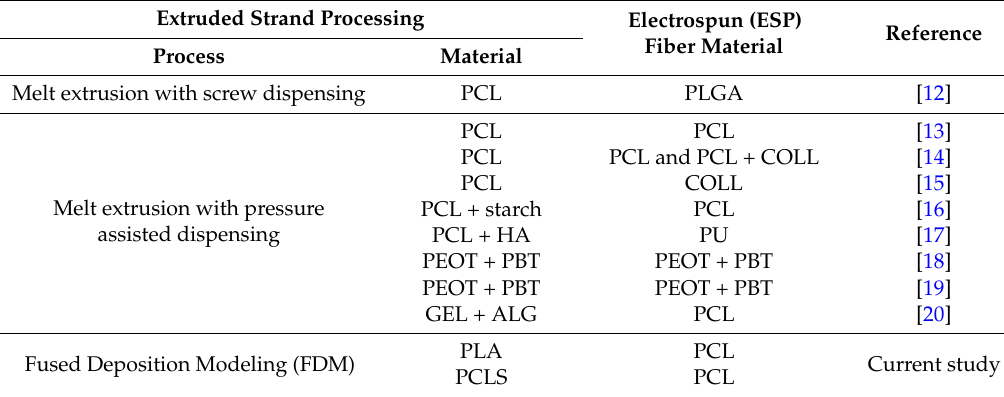
Table 1. Related works for bimodal scaffolds combining melt extrusion and